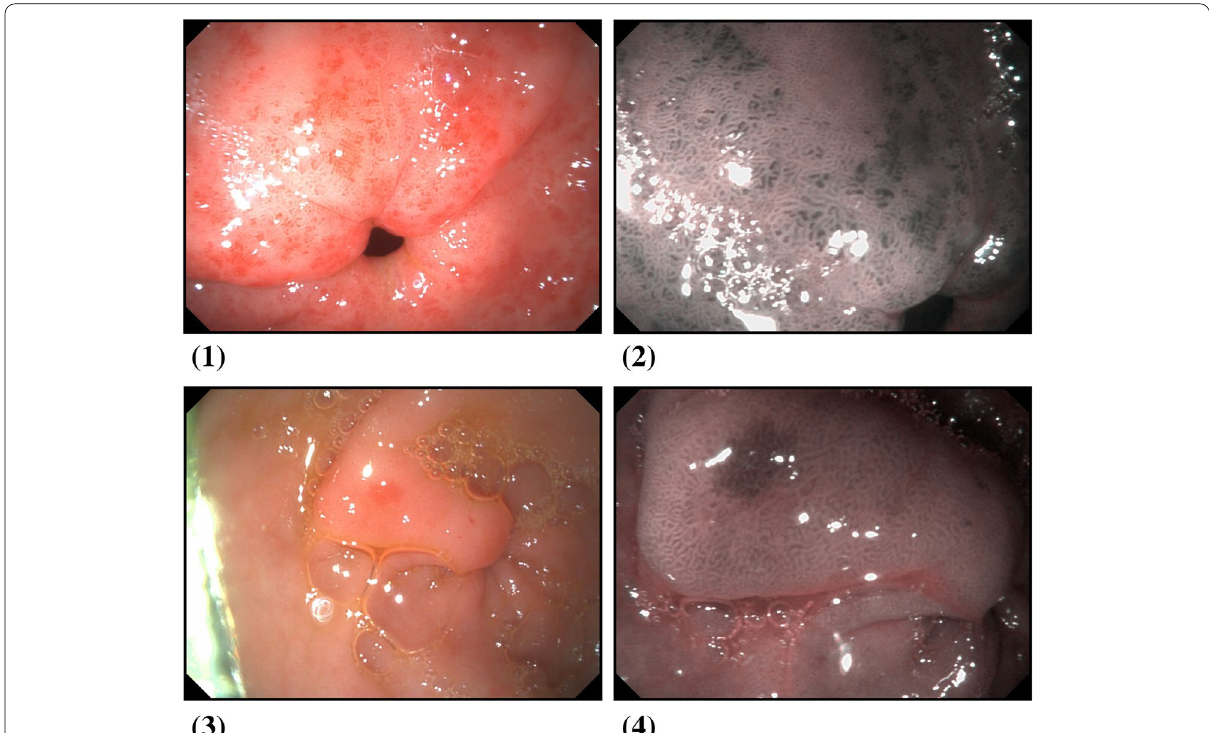
Fig. 1 WLE and VIST view of two forms of GAVE found in the studied patients: (1&2) GAVE diffuse type and (3&4) GAVE focal type respectively